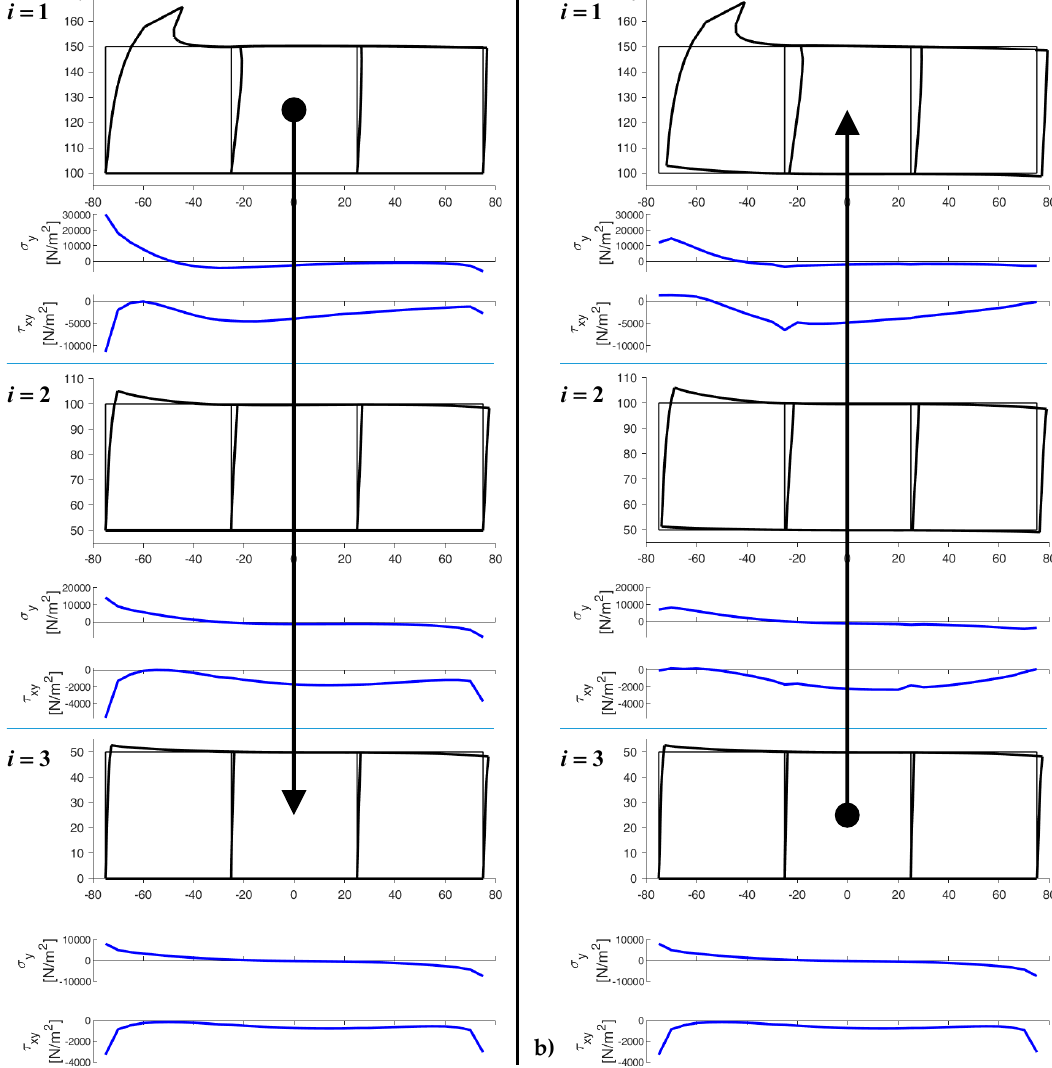
Figure 18. Deformed configurations and stress analysis on the constrained sides (the y -axis runs vertically) for the first top-to-bottom-to-top stabilization cycle on the rows. ( a ) In the first iteration from top to bottom, the i -th row generates the forces on the upper sides of the ( i + 1 ) -th row, with i = 1,2. ( b ) In the first iteration from bottom to top, the i -th row generates the displacements on the lower sides of the ( i − 1 ) -th row, with i = 3,2 (Thin line: undeformed configurations. Thick line: deformed configurations. Amplification factor of the displacements: k = 200 ).